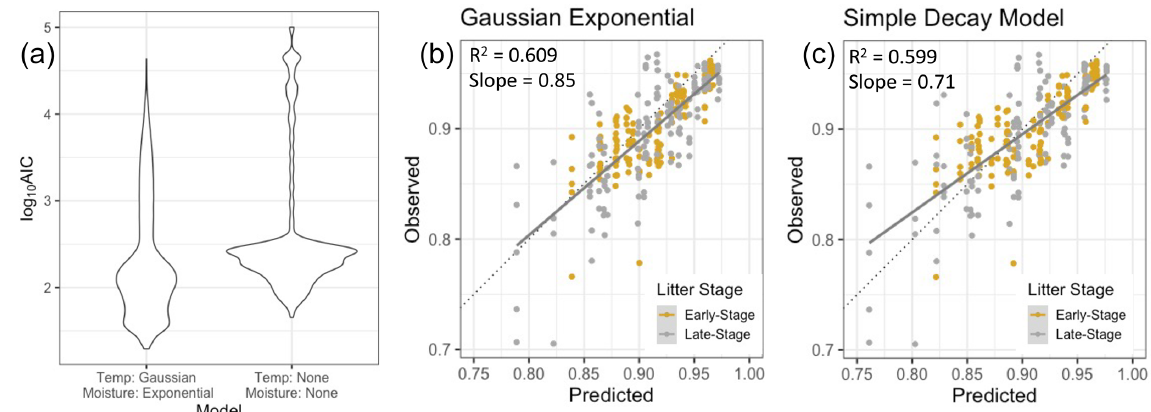
Figure 7. (a) Fit of the model using Gaussian temperature sensitivity and exponential moisture sensitivity vs. a simple exponential decay model (without temperature or NRM sensitivity) in which K eff is allowed to vary independently for each site (lower log 10 AIC scores denote better model fits). The simple decay model depicted here differs from the one in Fig. 6 because this one uses K eff and is not constrained to the same set of parameters. (b, c) Model predictions for the best version of the Gaussian exponential model versus the simple decay model with site-specific K eff values. Solid lines are the best fit lines and dotted lines are the ideal 1 : 1 line.